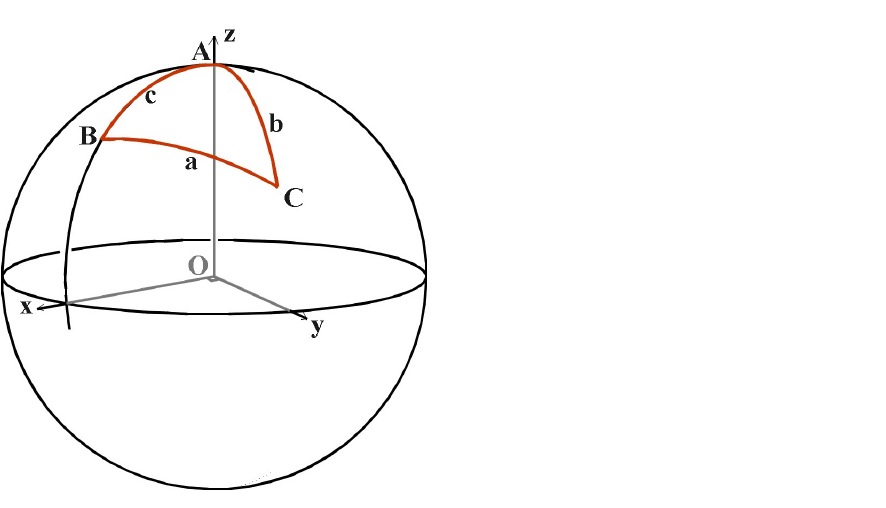
Figure 10. The geometry of 2-sphere embedded in three dimensional Euclidean